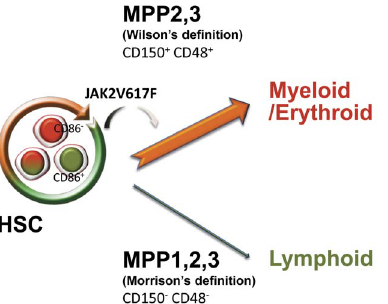
statistical analysis. Unpaired t-test analyses were employed, and p-values were considered significant if less than 0.05. Bars on figures depict Standard Error of the Mean.